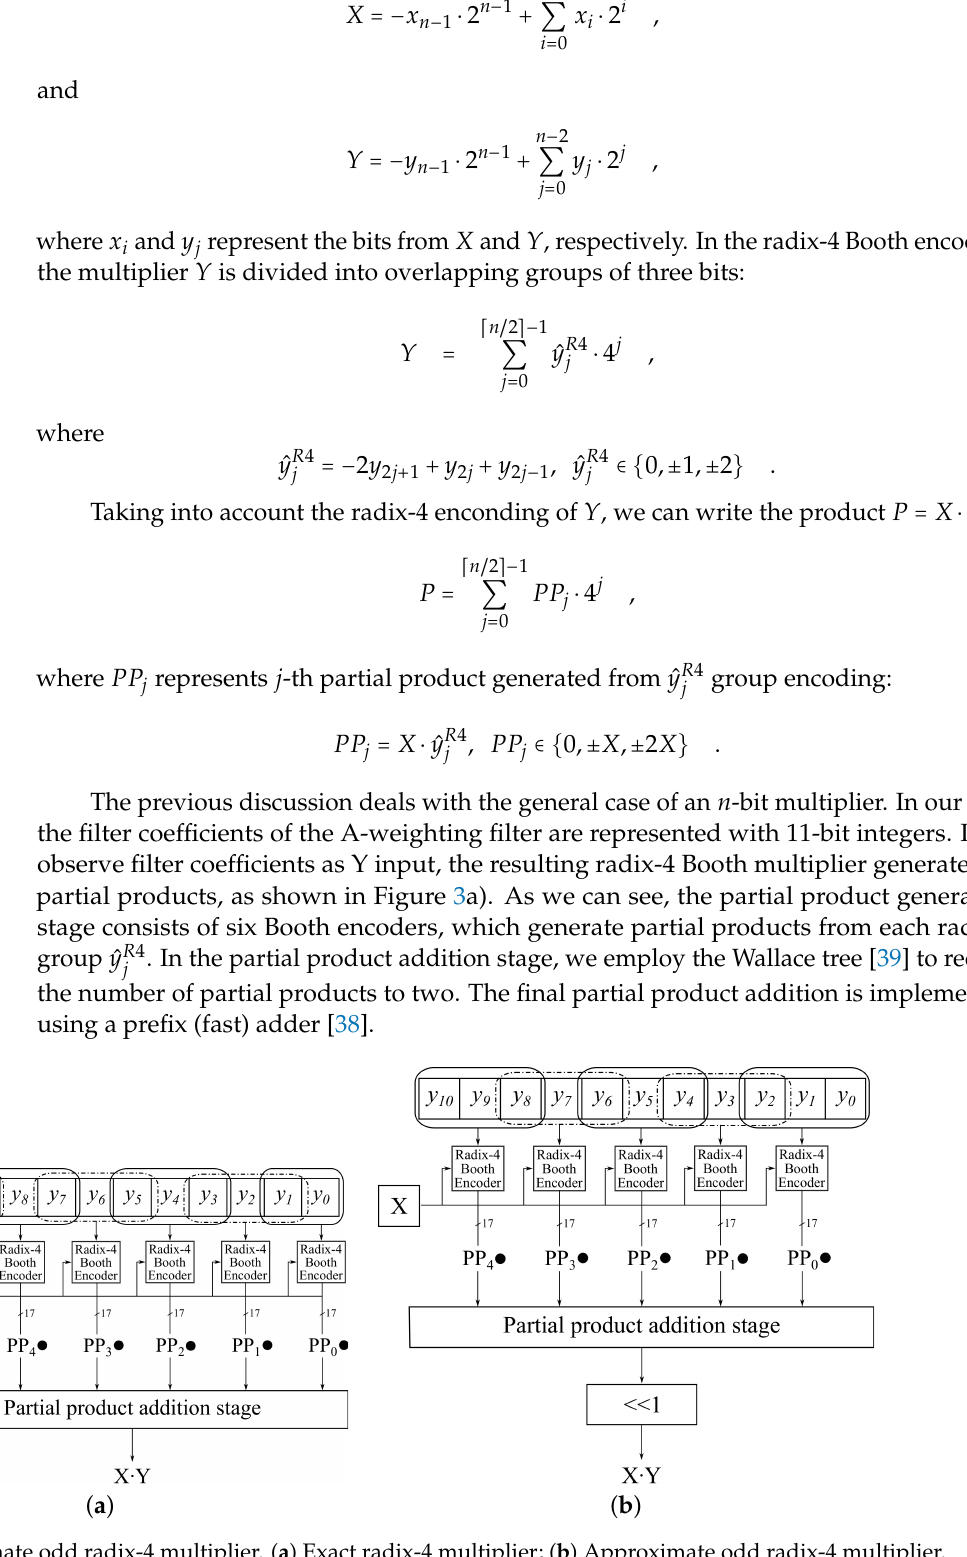
Figure 3. Exact and approximate odd radix-4 multiplier. ( a ) Exact radix-4 multiplier; ( b ) Approximate odd radix-4